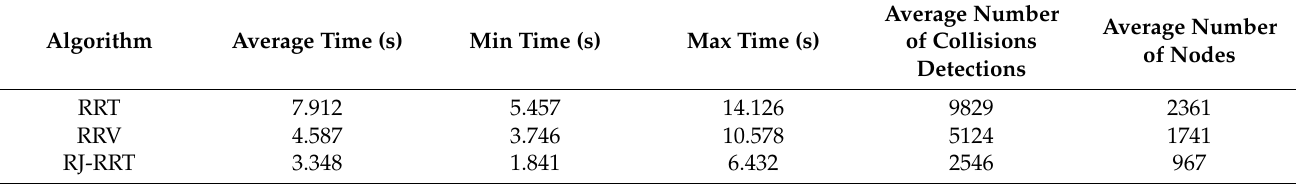
Table 4. When extended size is 0.3, the results of three algorithms in the bug